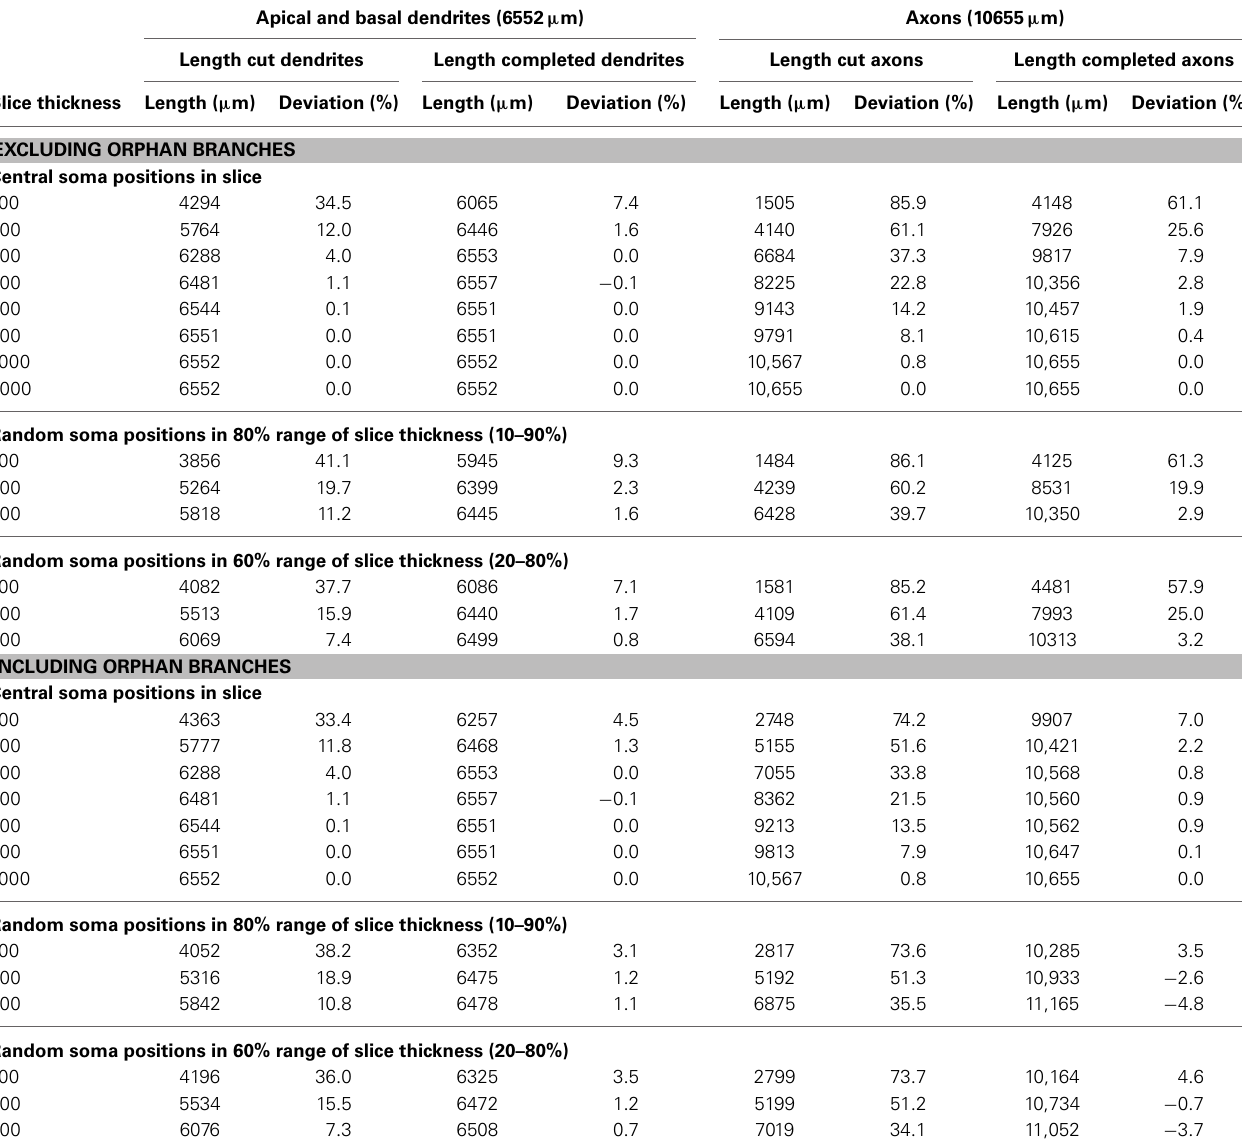
Table 1 | Effect of slicing on the length of apical and basal dendrites and axons, and the lengths after completion. Apical and basal dendrites (6552 µ m) Length cut